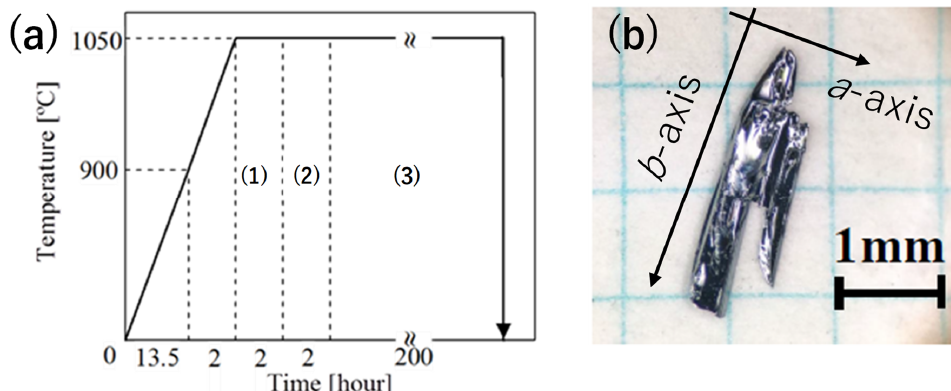
Figure 1. ( a ) Thermal conditions to obtain 1T’-MoTe 2 . (1–3) indicate the stabilizing furnace, prepa- ration slope, and temperature stability processes, respectively. At first, the furnace was heated up to 1050 °C for 15.5 h and maintained for 2 h for temperature stabilization (1). Next, the high and low-temperature ends were set to 1050 °C and 950 °C for 2 h, respectively (2). The temperature condition was maintained for 200 h (3). Thereafter, quartz tubes were immersed in water to avoid 2H structure formation (hexagonal crystal), which is known to be stable at approximately 800 °C. ( b ) Image of the 1T’-MoTe 2 single crystal sample prepared by chemical vapor deposition.